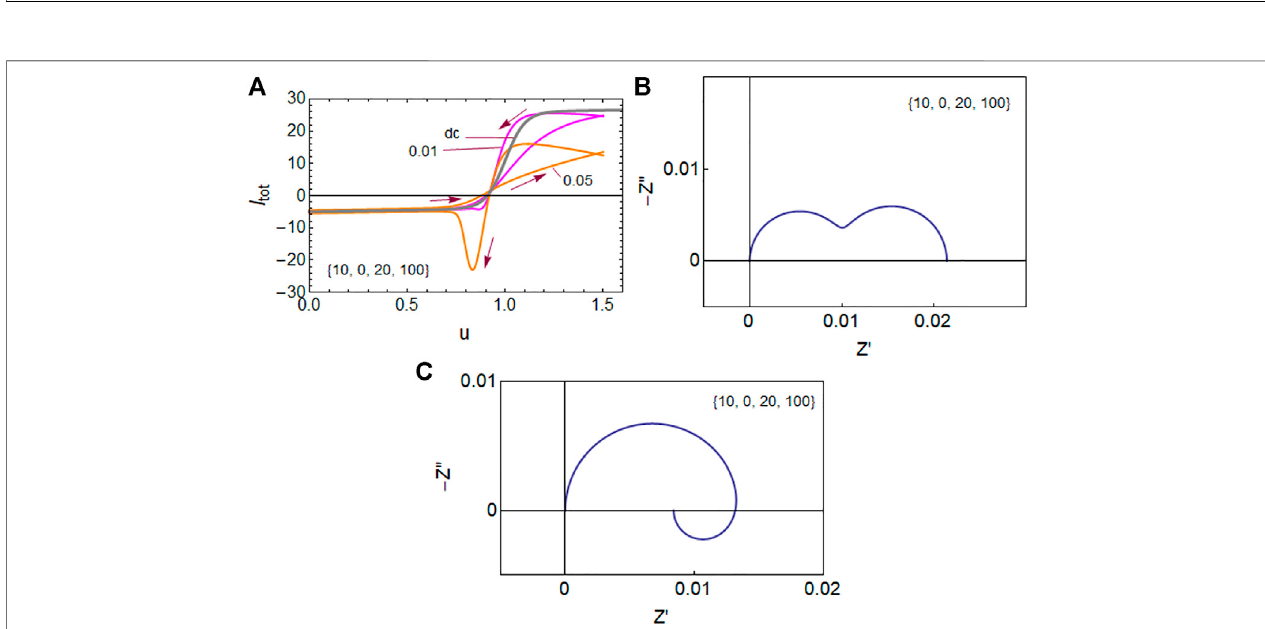
FIGURE 15 | Calculation of a memristor/solar cell model. (A) Current at forward and backward scan at different rates as indicated. The grey line is the total equilibrium dc current (B) Impedance spectrum at u (cid:2) 0 . 95. R b = 1; C m (cid:2) 0 . 001, i c 0 = 100, I ph (cid:2) − 10, V T (cid:2) 1, V m = 0.05, α (cid:2) 0, [ τ m , τ d , τ k , Q m ] . (C) Current at forward and backward scan at different rates as indicated. R b = 1; C m (cid:2) 0 . 001, i c 0 = 30, I ph (cid:2) − 10, V T (cid:2) 1, V m = 0.05, α (cid:2) 0 . 5, [ τ m , τ d , τ k , Q m ] .